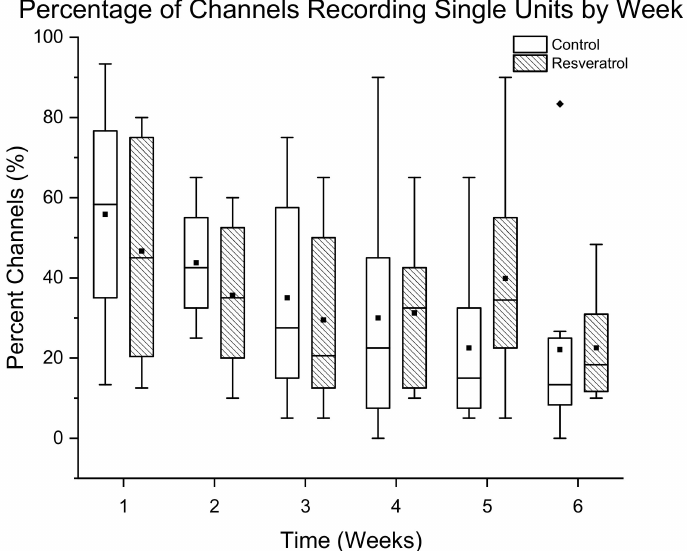
Figure 3. Assessment of recording performance defined as the percentage of channels detecting single units in animals administered resveratrol via intraventricular delivery (dashed box) compared to control animals (white box). No significant differences in the percentage of channels recording single units was seen for the duration of this study. N = 8 animals per group. The whiskers represent the range within 1.5 IQR, the lines inside the boxes represent the median line, the solid squares in the middle represent the mean and the diamonds represent